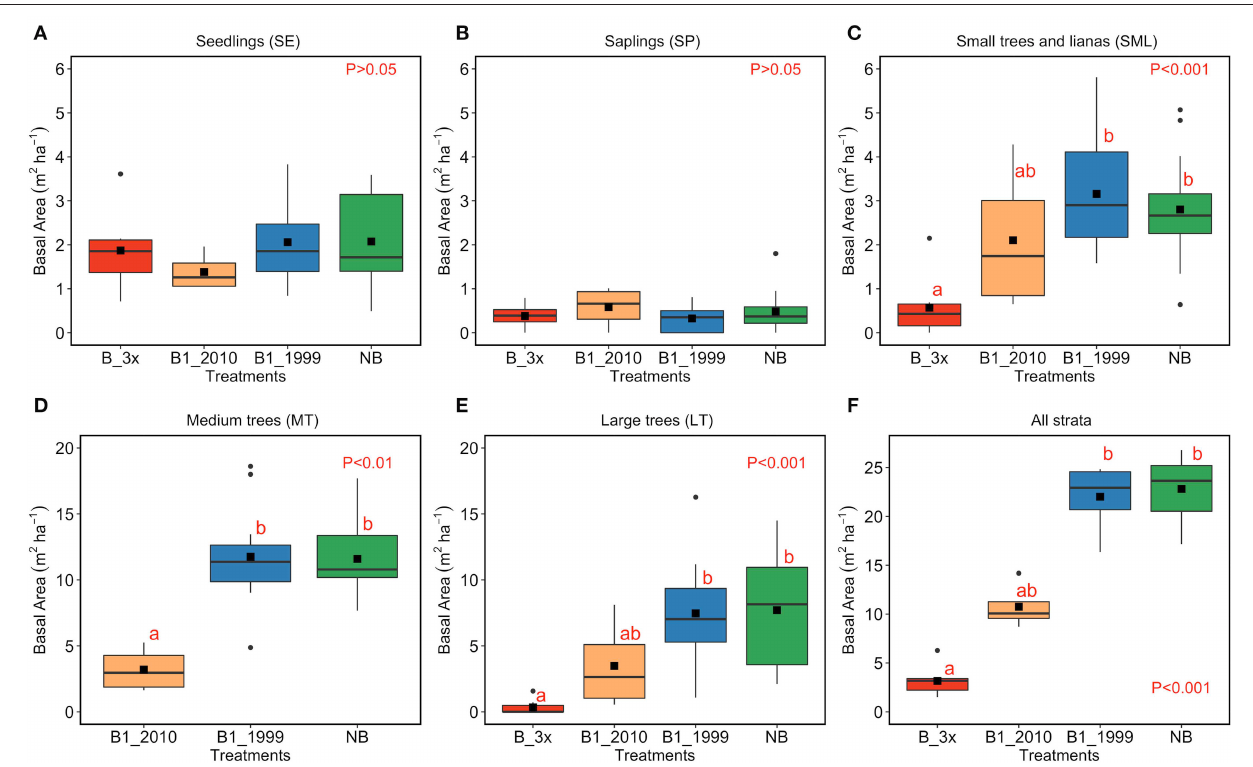
FIGURE 5 | Basal area (m ² ha − 1 ) in each stratum and according to fire regimes. Analyses were conducted separately for each vegetation strata (A) SE, (B) SP, (C) SML, (D) MT, (E) LT, and (F) for all strata together. LT stands for large trees, MT for medium trees, SML for small trees and woody lianas, SP for saplings, and SE for seedlings. The p -values indicate whether comparisons were statistically significant according to Kruskal–Wallis tests, and the lowercase letters above bars show differences among treatments. The line crossing bars indicate the median, the solid square denotes the mean, the boxes account for the 25th and 75th percentiles and vertical lines are the minimum and maximum